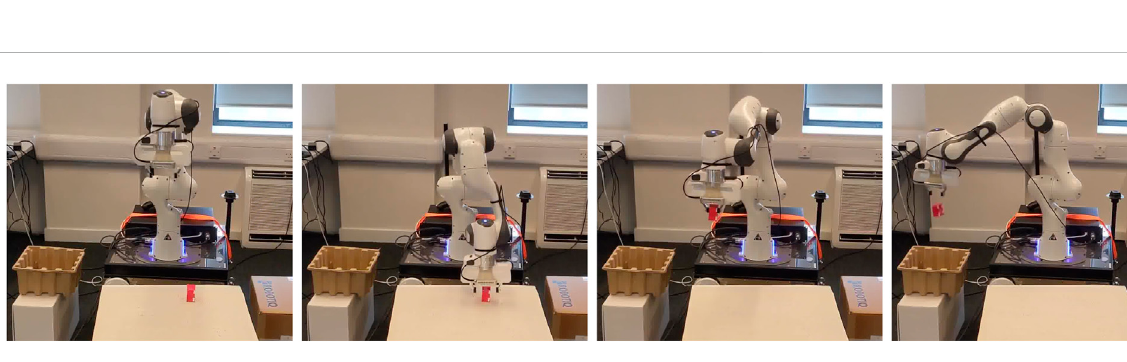
FIGURE 9 Physical robot setup: goal object to pick is in red, while the goal place is the box on the left.